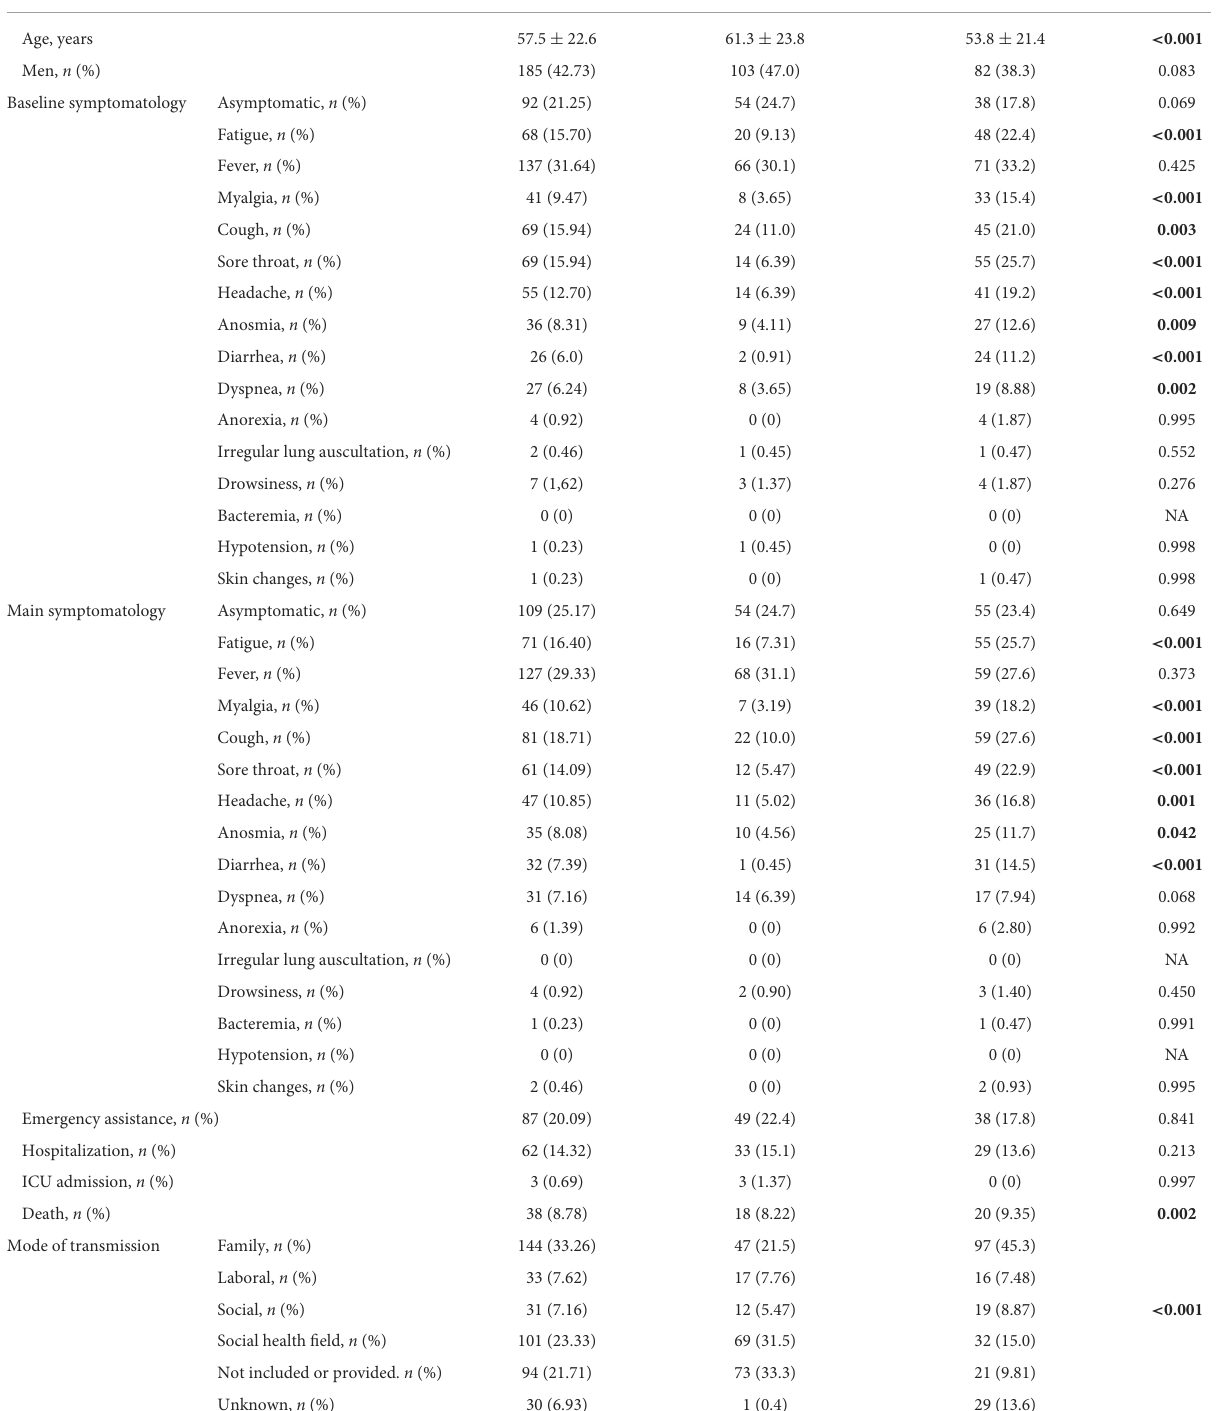
TABLE 1 Clinical characteristics according to the demographic